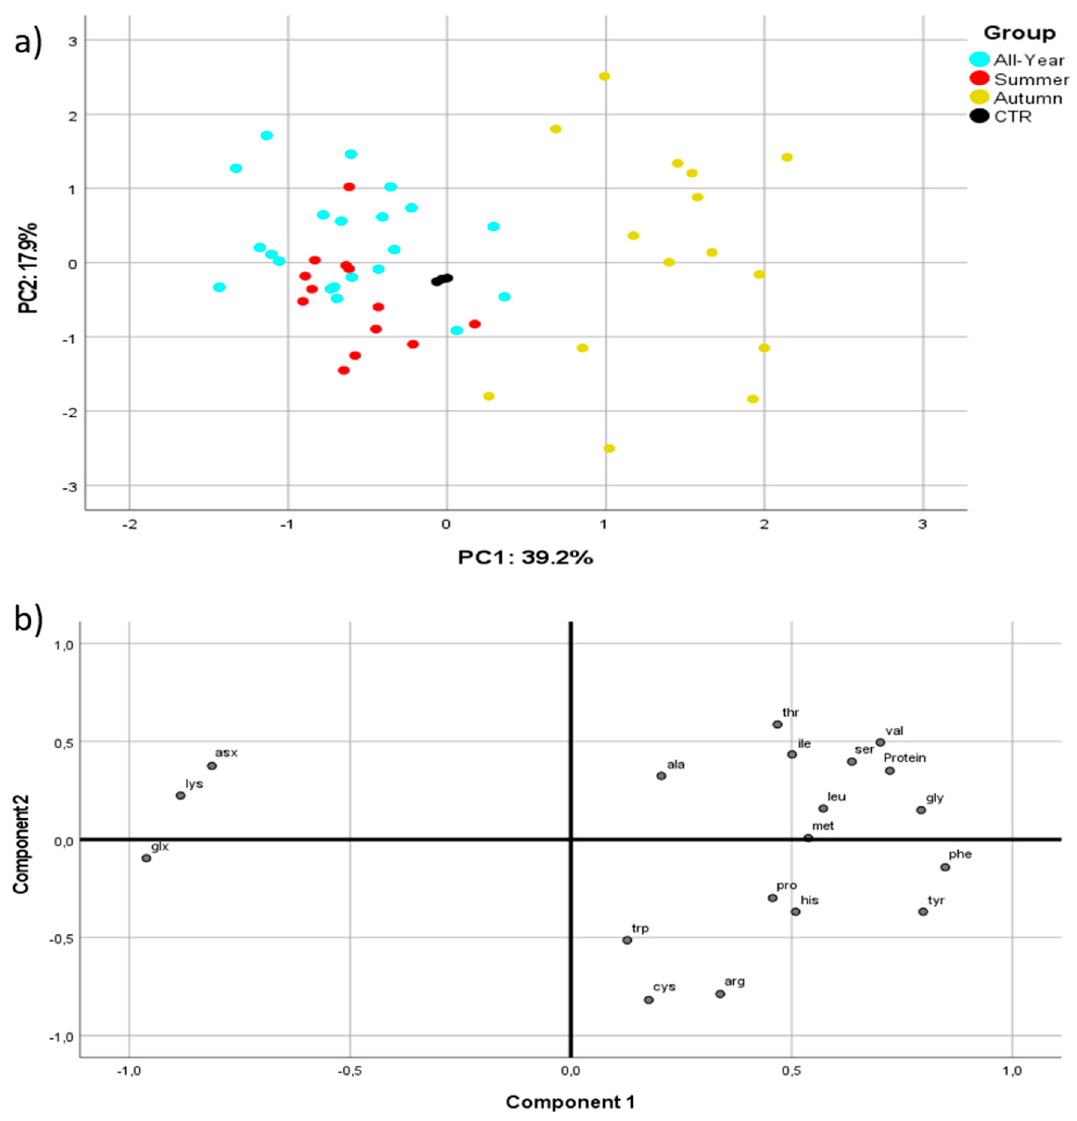
Figure 4. ( a ) Score plot of BSF samples on the first two principal components; ( b ) loadings values of the variables associated with the first two principal components.